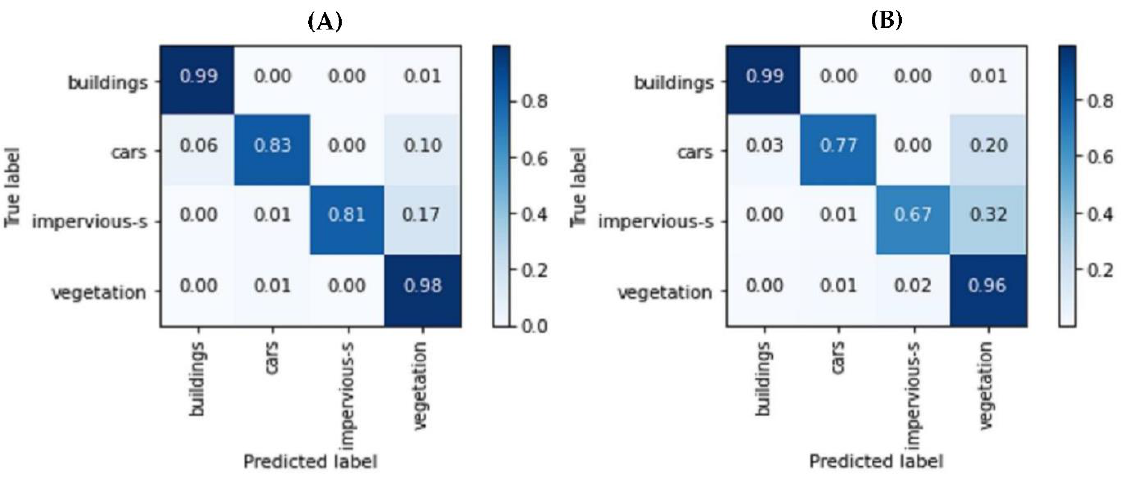
Figure 10. Normalized confusion matrix of the proposed approach ( A ) and the non-fusion approach ( B